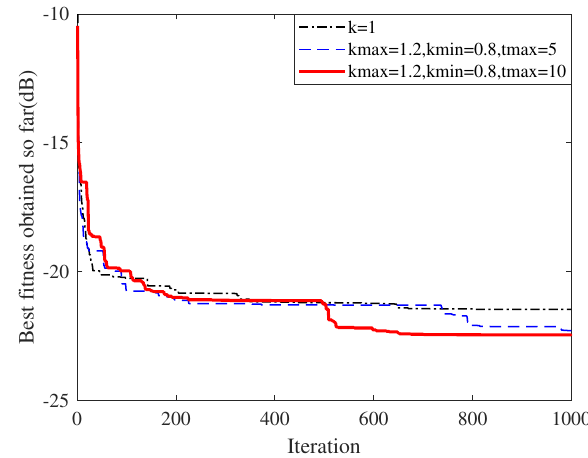
Figure 12. The iterative process under three sets of RL